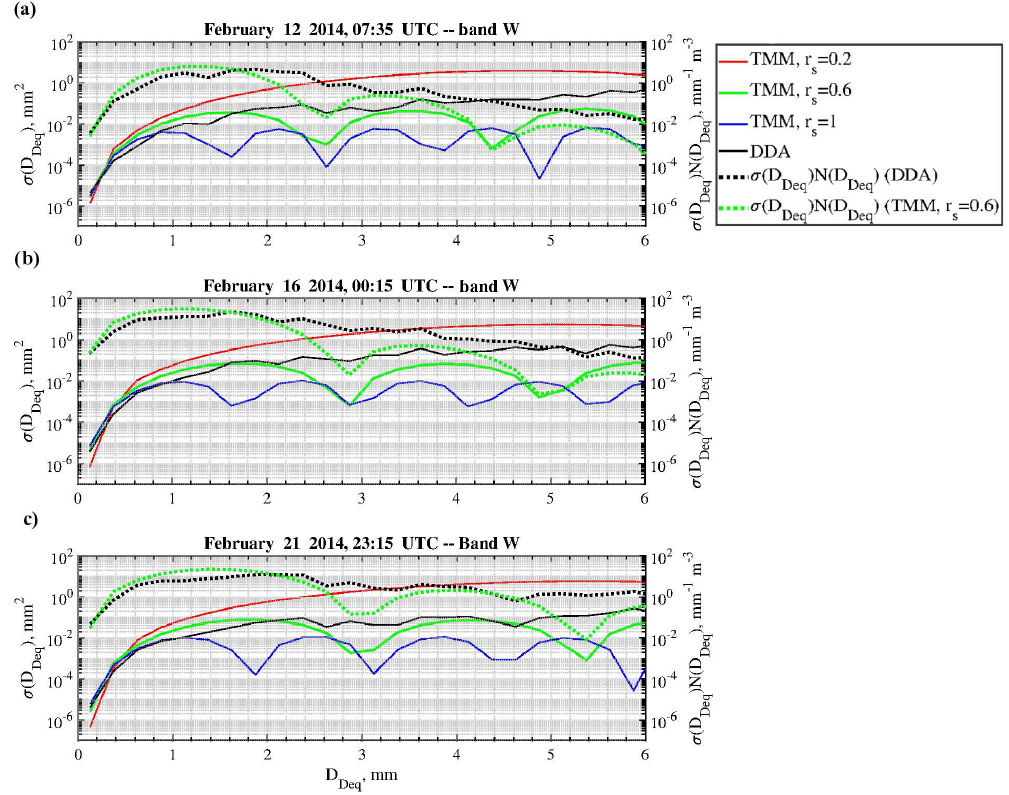
Figure 12. Horizontally polarized cross section σ , expressed as a function of the diameter disk-equivalent D Deq at W band by comparing DDA computations (black line) and TMM computations (red, green and blue lines, matching r s = 0 . 2, r s = 0 . 6 and r s = 1). The product between σ and PIP-derived snowflake size distribution N shows the main contribution of particle size in terms of diameter disk-equivalent for DDA computations (dotted black line) and TMM computations ( r s = 0 . 6, dotted green line).